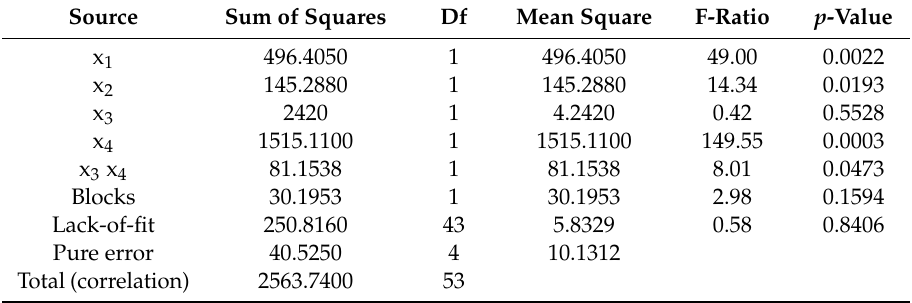
Table 6. Analysis of variance: the empirical model for predicting the sum of higher